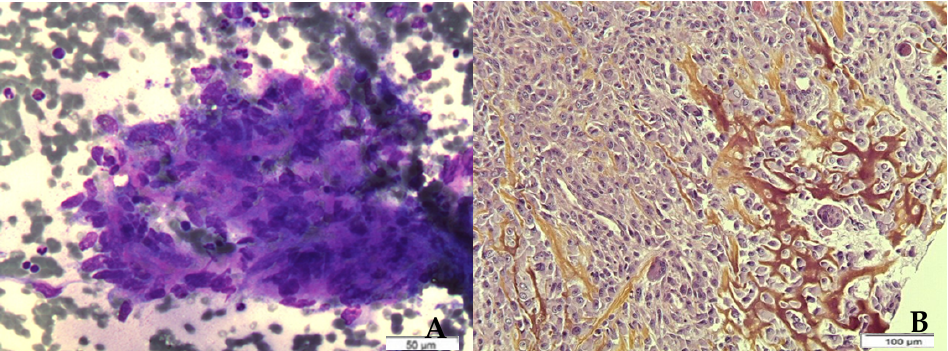
Figure 1. Radiation-induced osteosarcoma. ( A ): smears showing clustered spindle and pleomorphic sarcomatous cells associated with pinkish/orange osteoid (May-Grunwald–Giemsa, 400×; Merck, Darmstadt, Germany); ( B ): corresponding surgical sections of spindle-shaped and epithelioid proliferation showing osteogenesis (Hematoxylin-Eosin-Safran,200×; Merck, Darmstadt, Germany). Schemes follow the same formatting.